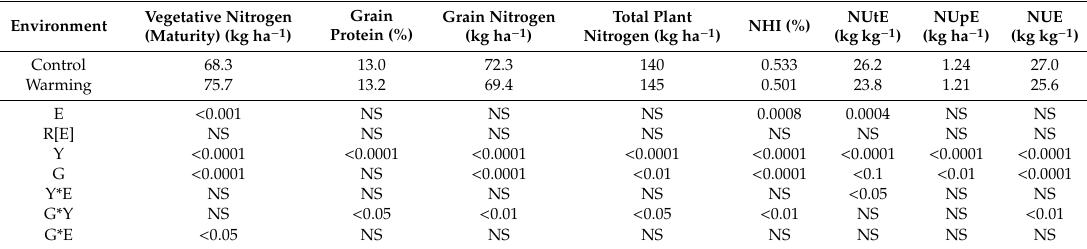
Table 4. Least squares means for nitrogen traits † measured on a panel of 36 soft red winter wheat genotypes under ambient and passively warmed conditions, 2015–2016 Lexington, KY. Least squares means were calculated from the combined ANOVA over years. Significance of mean squares shown below least squares